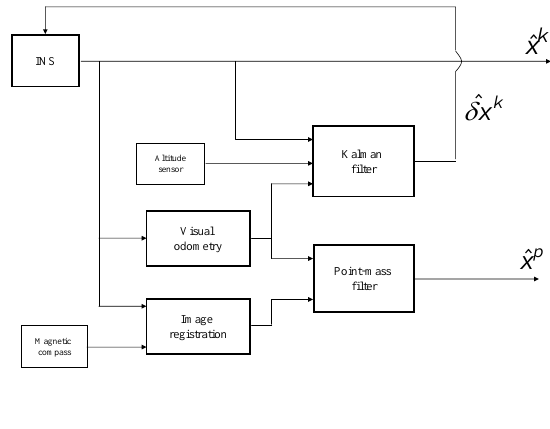
Figure 2: Sensor fusion